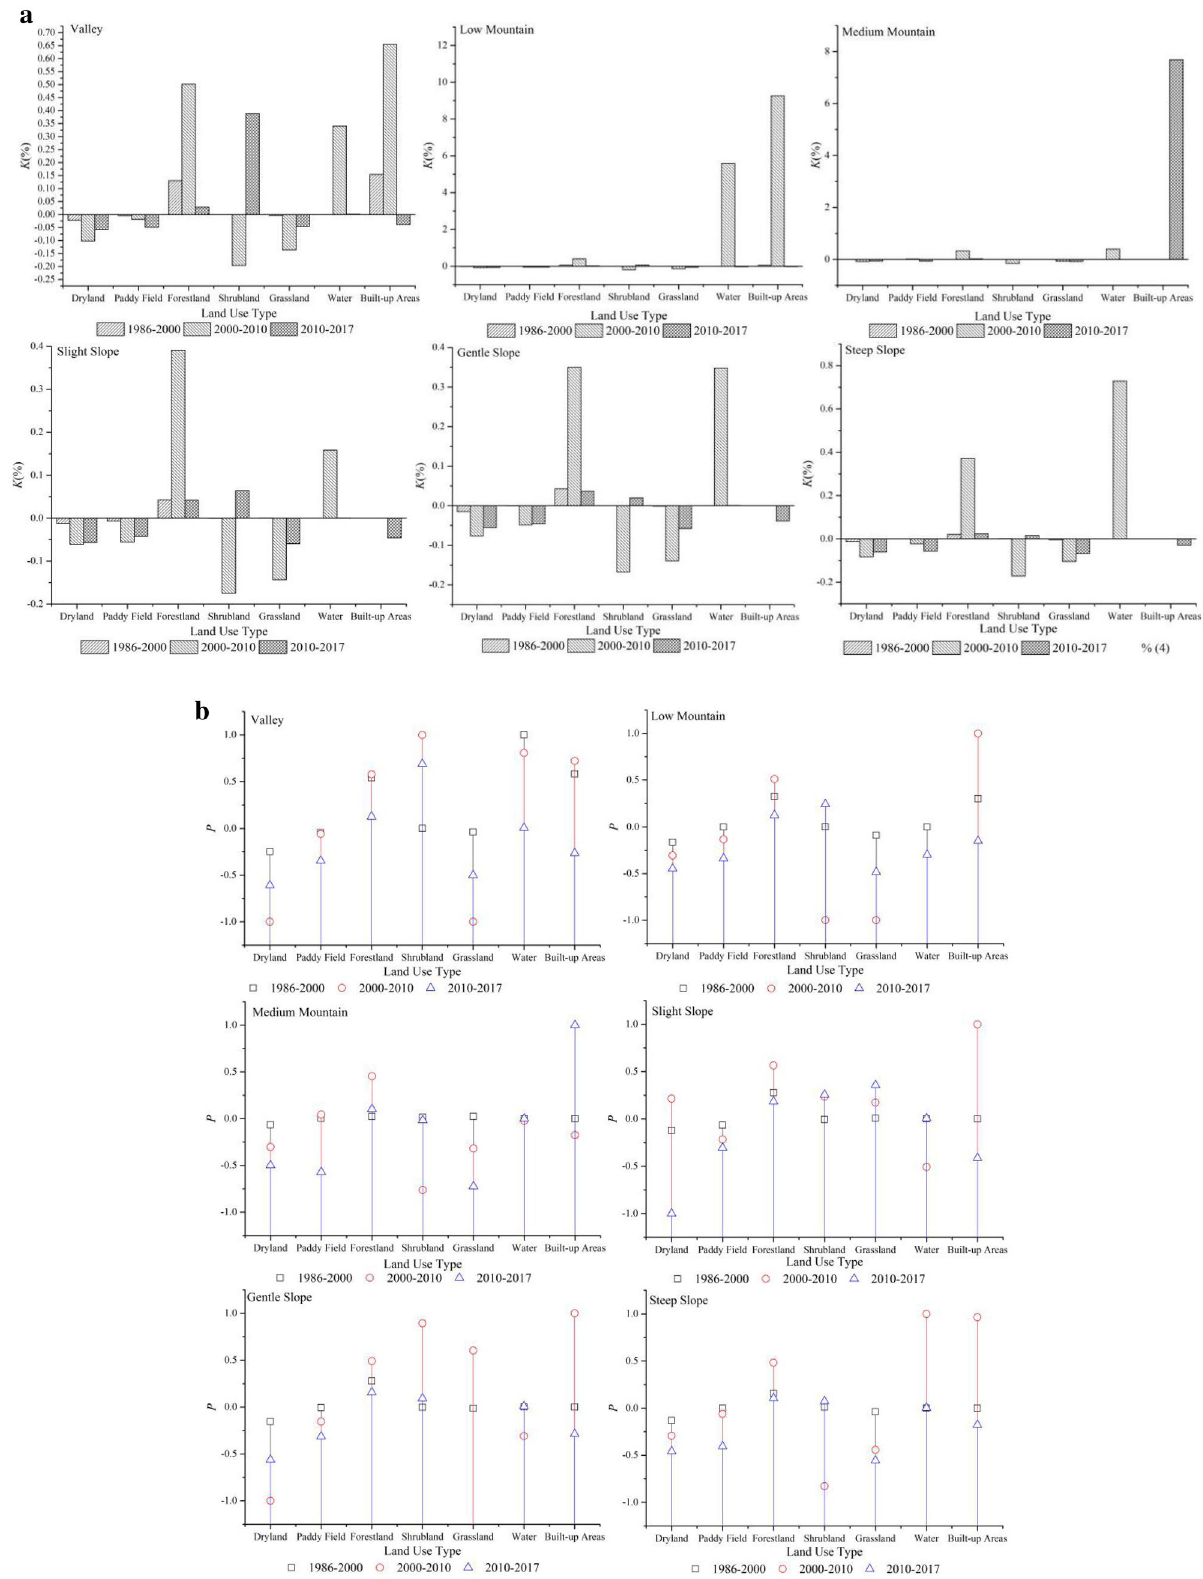
Figure 5. ( a ) Speed of different land cover for different landforms of the watersheds, ( b ) The trend of different landscape types for different landforms of the